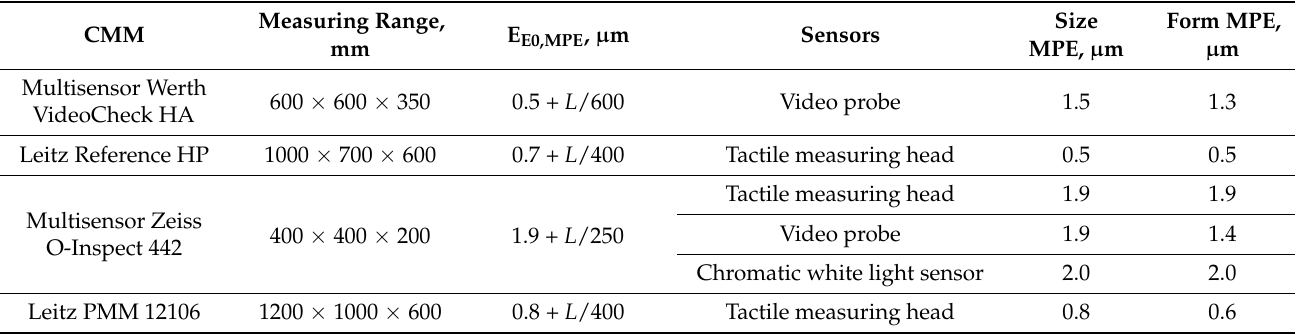
Table 2. Sensor types, measuring volumes and specifications of CMMs used in experiment. In E E0,MPE column L is measured distance given in mm.